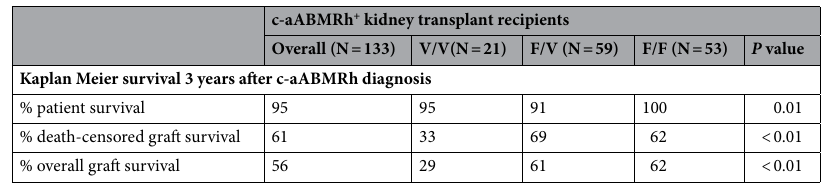
Table 3. FCGR3A 158 F/V genotypes of c-aABMRh kidney transplant recipients and survival.